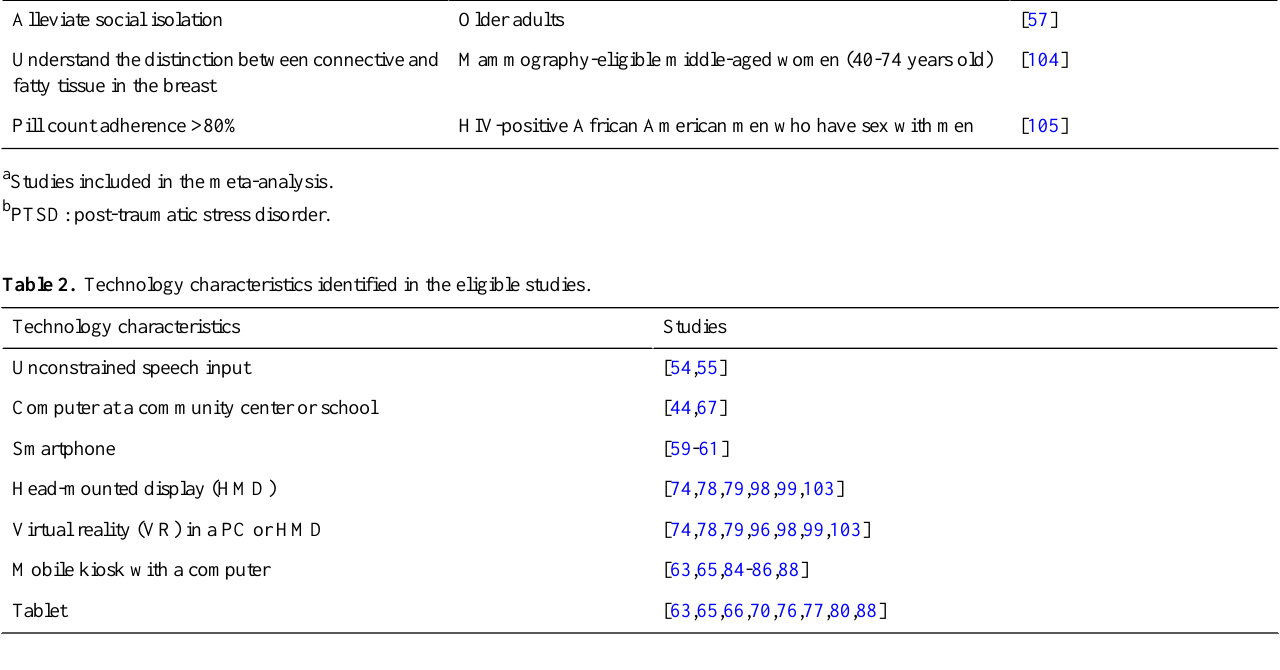
Table 3. Two broad categories of virtual humans emerged from the 53 articles included in the qualitative review.